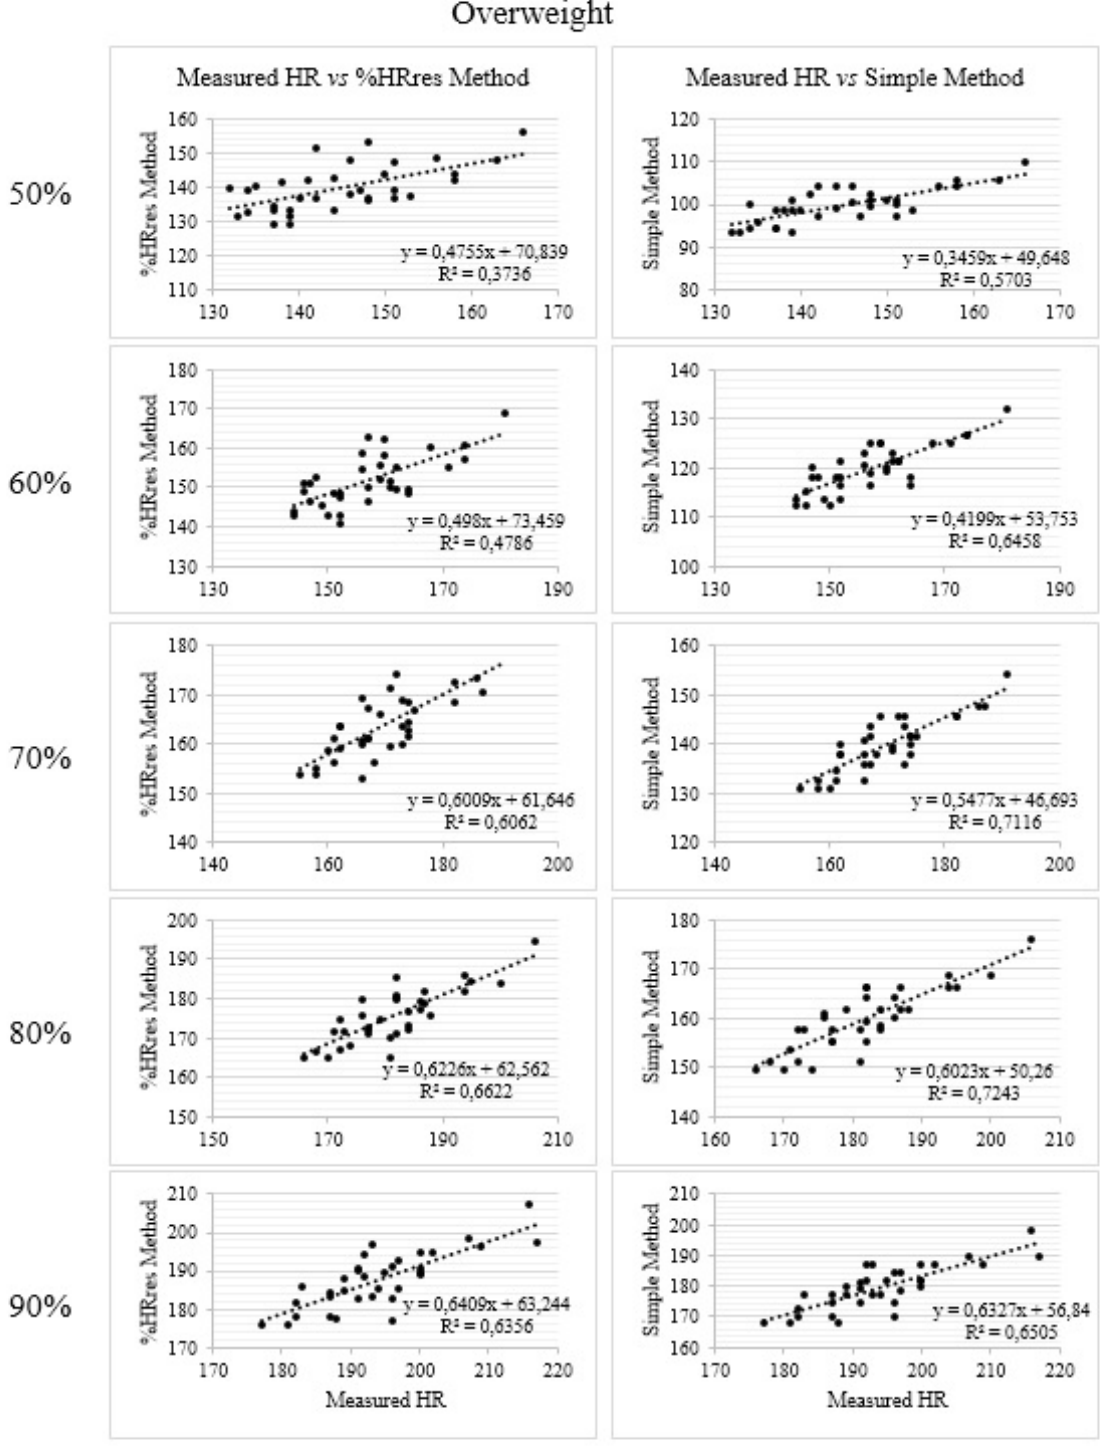
Figure 2. Correlation between measured HR vs. predicted %HRres method and measured HR vs predicted simple method (HRmax) in overweight in both sexes